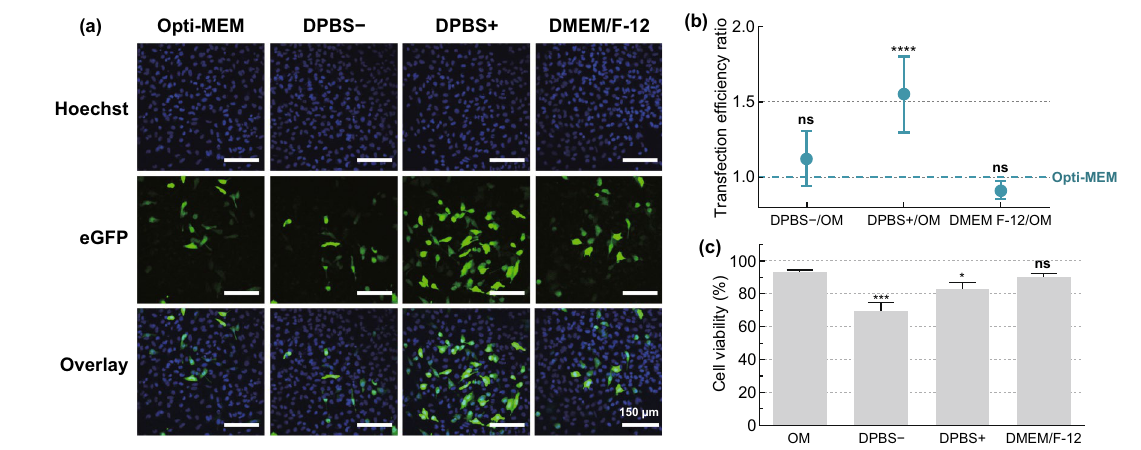
Fig. 3 Screening of transfection buffers for mRNA transfection in HeLa cells. HeLa cells were transfected with eGFP-mRNA by VNB pho- toporation (0.3 µM mRNA; 8 × 10 7 AuNPs mL −1 ; 3.6 J cm −2 ) using different transfection buffers: Opti-MEM (OM), DPBS−, DPBS+ or DMEM/F-12. a Representative confocal microscopy images of HeLa cells 24 h after transfection (Scale bar = 150 µm). b Transfection efficiency ratios for different buffers compared to OM, as measured by flow cytometry ( n = 6). A one-way ANOVA with Dunnett’s multiple comparison test was performed to determine statistical differences between OM and the other buffers ( ns = nonsignificant; **** p < .0001). c Cell viability 24 h post transfection, expressed relatively to the untreated control ( n = 3). A one-way ANOVA with Dunnett’s multiple comparison test was per- formed to determine statistical differences between OM and the other buffers ( ns = nonsignificant; * p < .05; * * * p < .001)